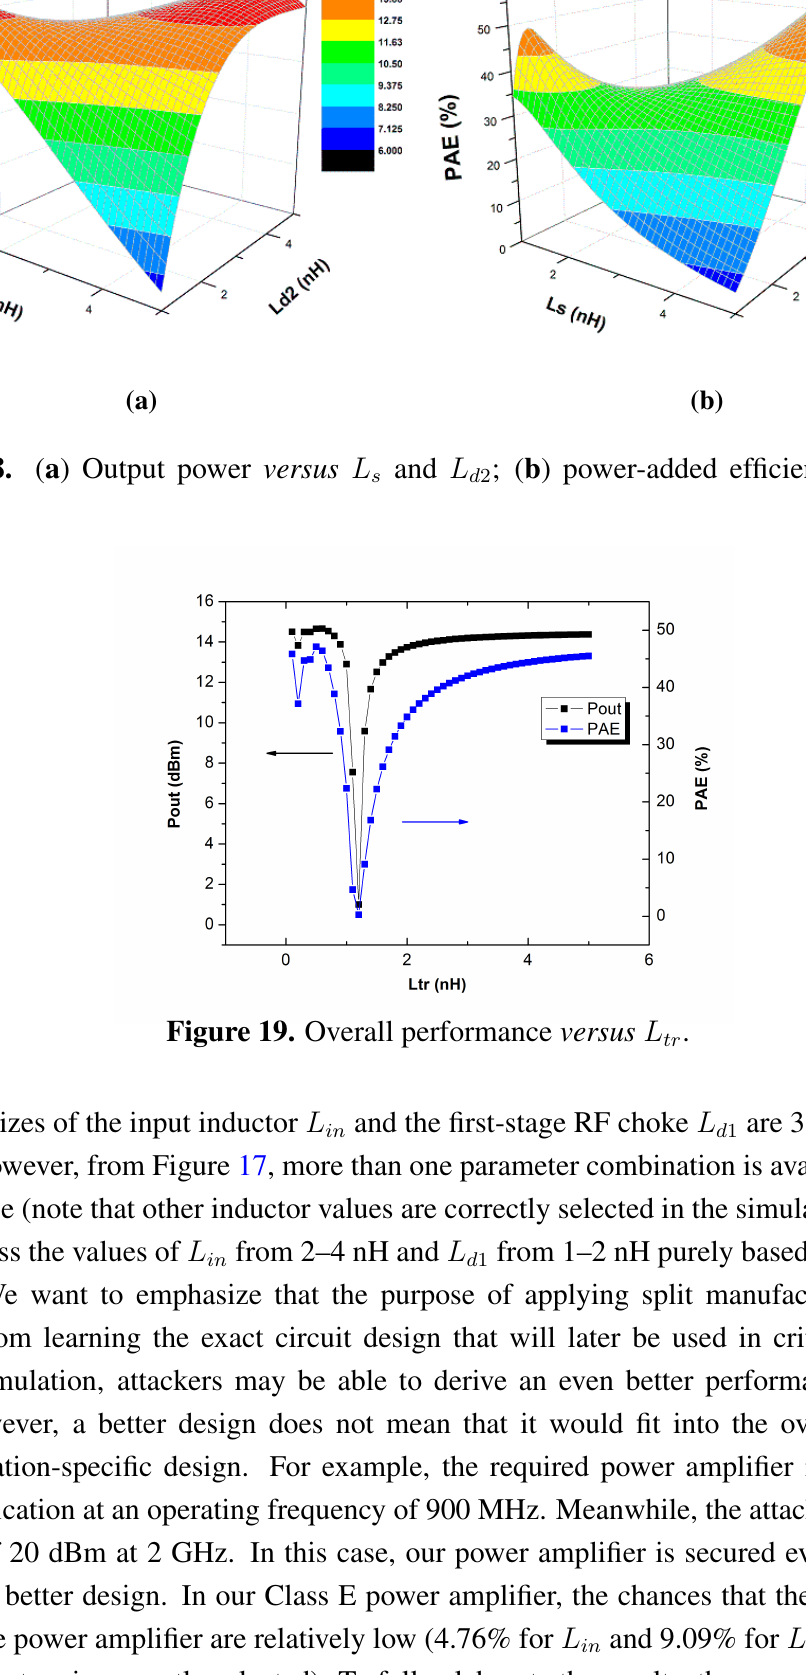
and L ; ( b ) power-added efficiency versus L s d 2